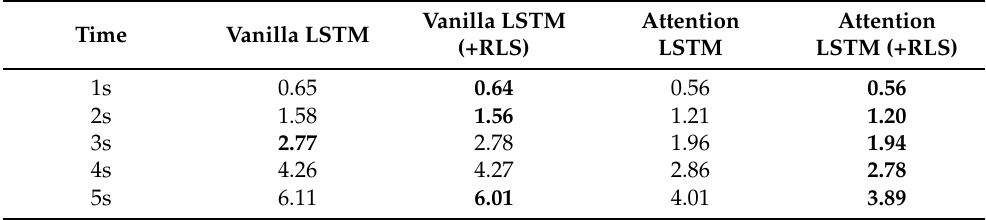
Figure 4. Results of perturbation occurrence. We make a comparison of our model RRN with CS- LSTM. Table 3. RMSE (in meters) results of ablation study. Vanilla LSTM (+RLS) and Attention LSTM (+RLS) stand for Vanilla LSTM with parametric-learning RLS and Attention LSTM with parametric- learning